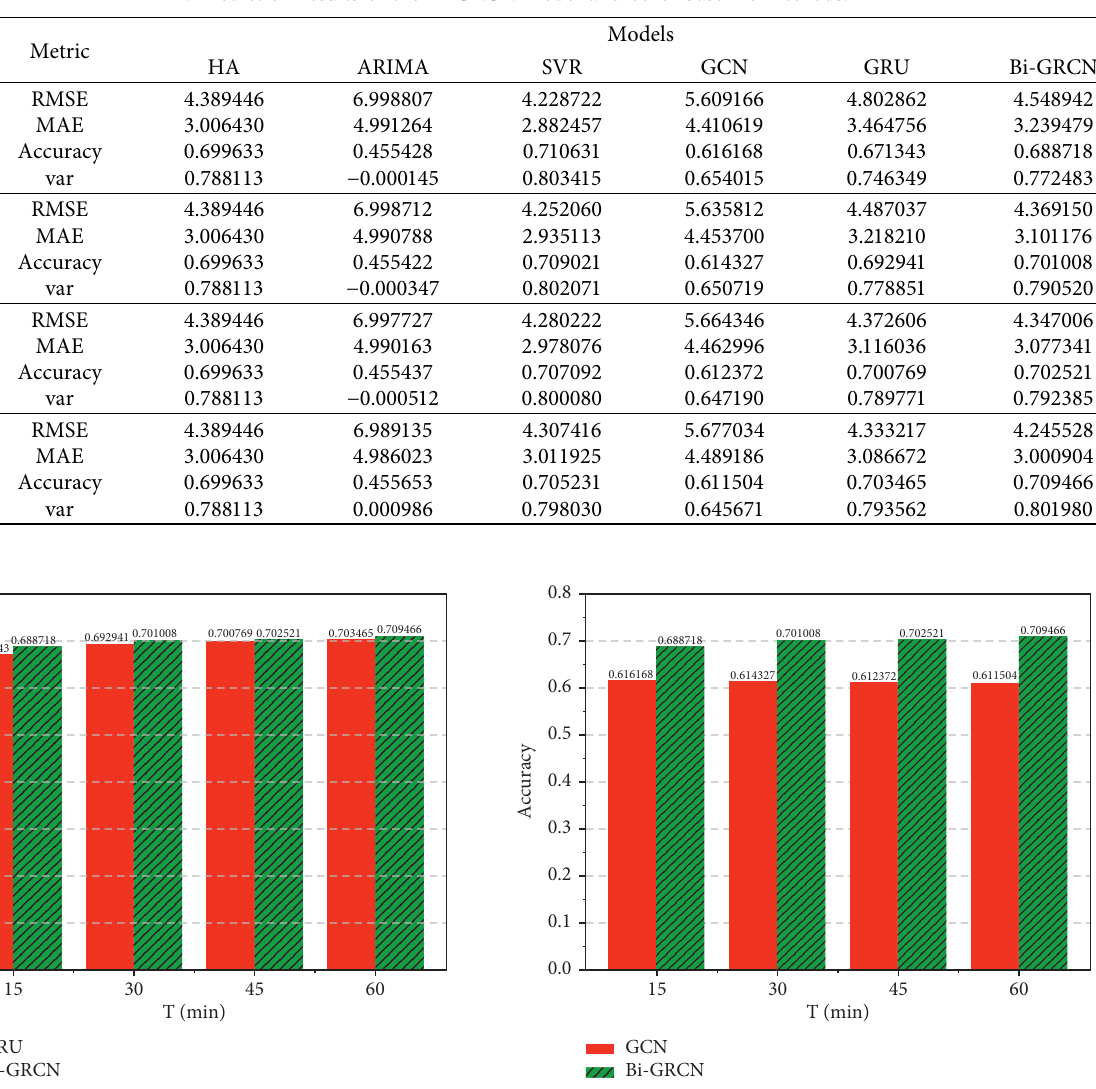
Figure 8: Accuracy and var change with the number of hidden units. Table 1: Prediction results of the Bi-GRCN model and other baseline methods.